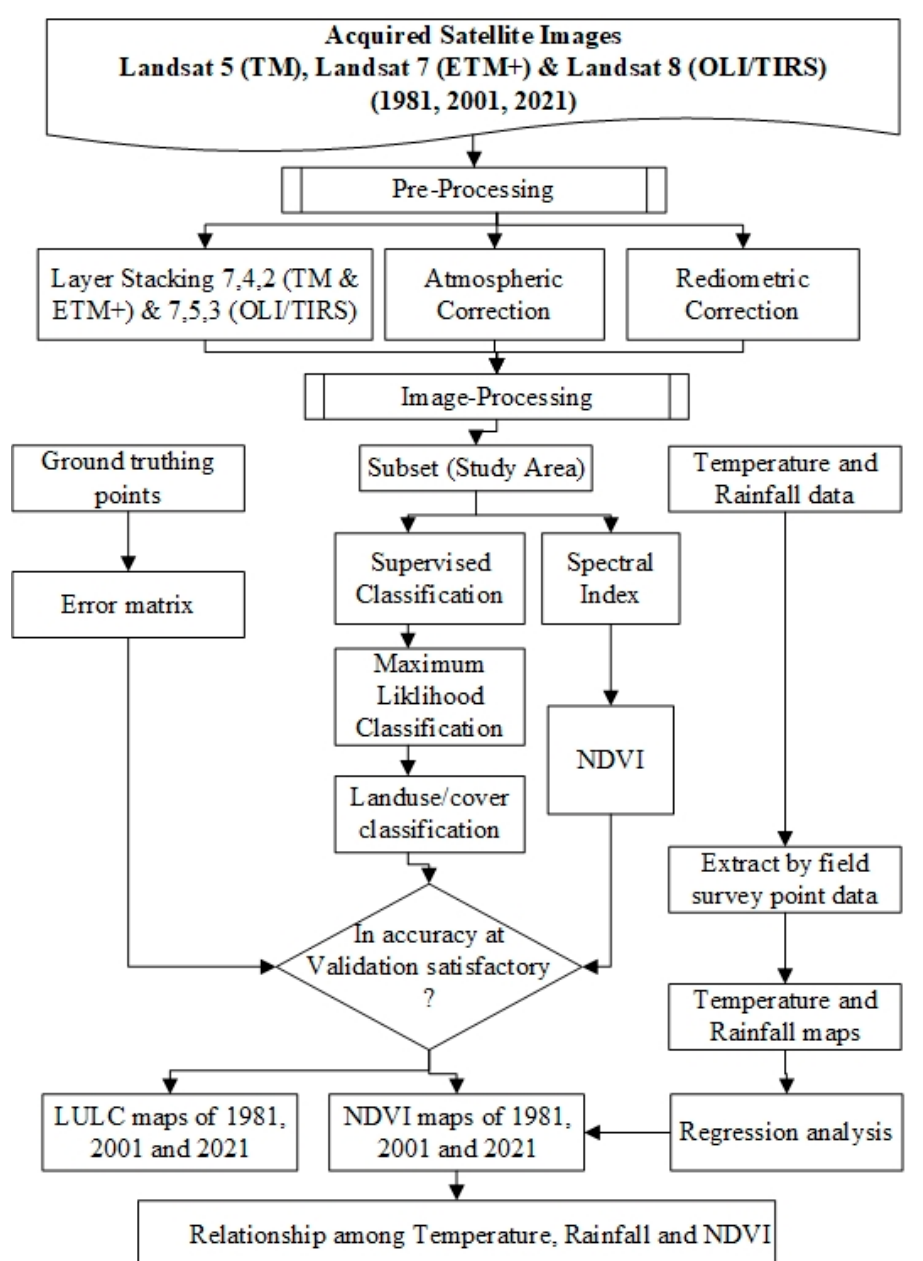
Figure 2. Flow chart for